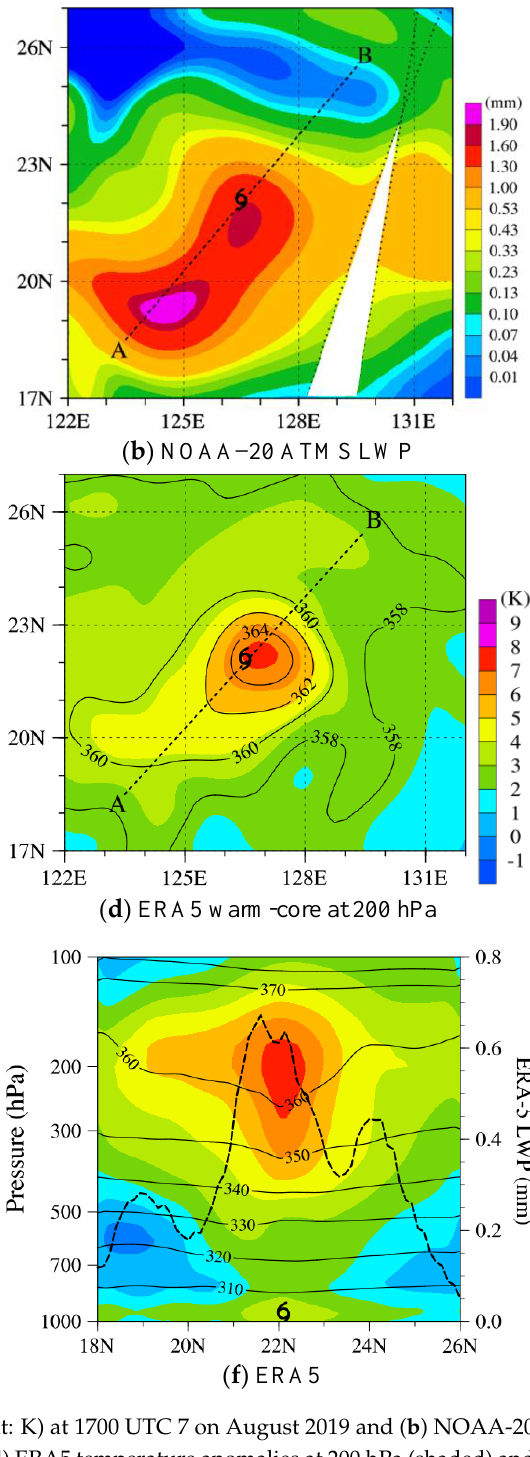
( a ) MWTS−2 ( b ) ERA−5 Figure 14. T emporal evolutions of the radial variation in ( a ) MWTS-2 retrieved temperature anomalies and ( b ) ERA5 temperature anomalies at 250 hPa within a 500-km radial distance along the west-east direction from the center of Typhoon Lekima from 2 to 14 August 2019.